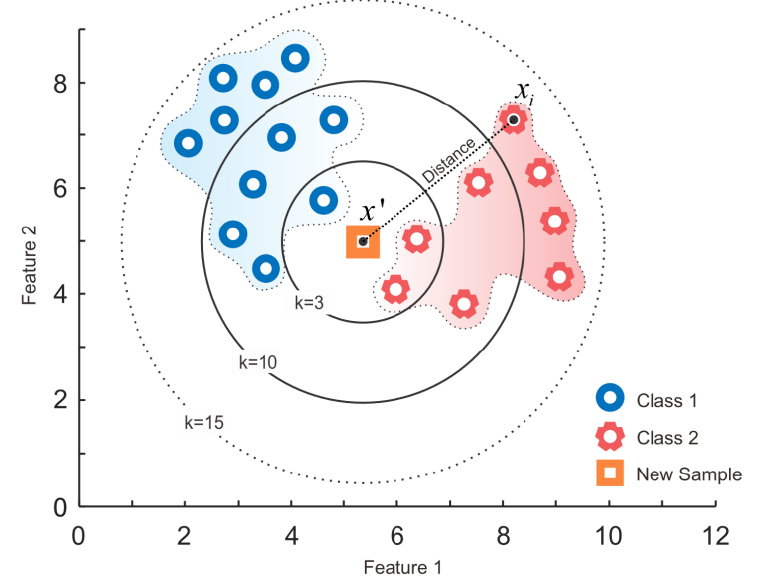
Figure 12. Schematic explanation of the k-NN algorithm.